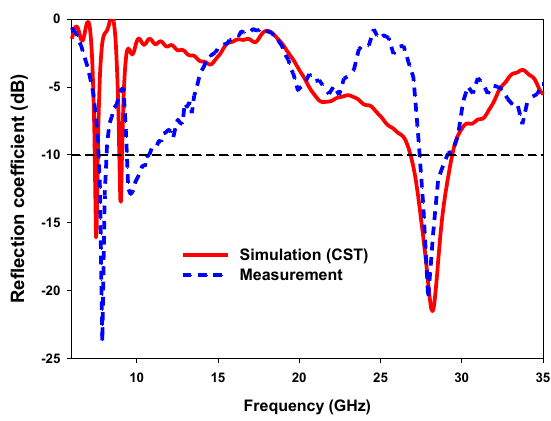
FIGURE 7. Measured and simulated results of reflection coefficient for the proposed